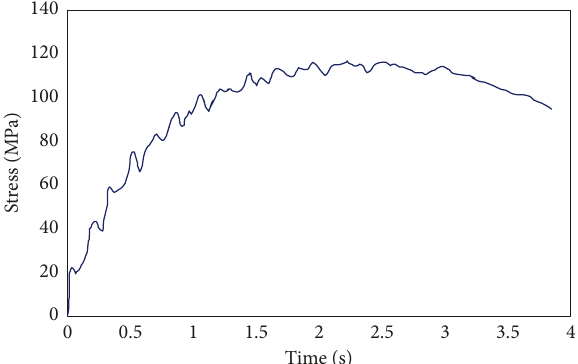
Figure 14: Stress change curve of the node.